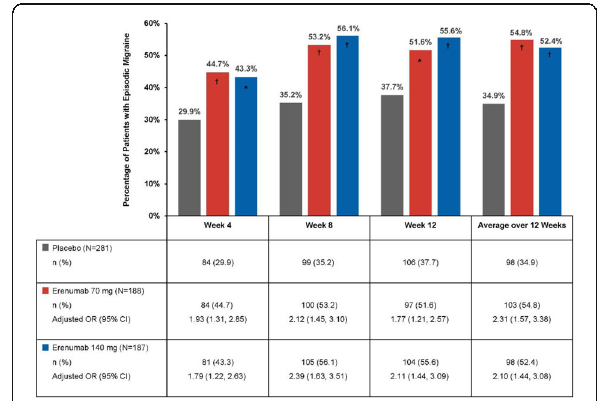
Fig. 1 (abstract P42). Conversion to episodic migraine during the 12-week double-blind phase . Odds ratio (OR) was obtained from a Cochran-Mantel-Haenszel test and stratified by region and medication overuse. Each erenumab dose group was compared with placebo. † p<0.001, *p=0.003. CI, confidence